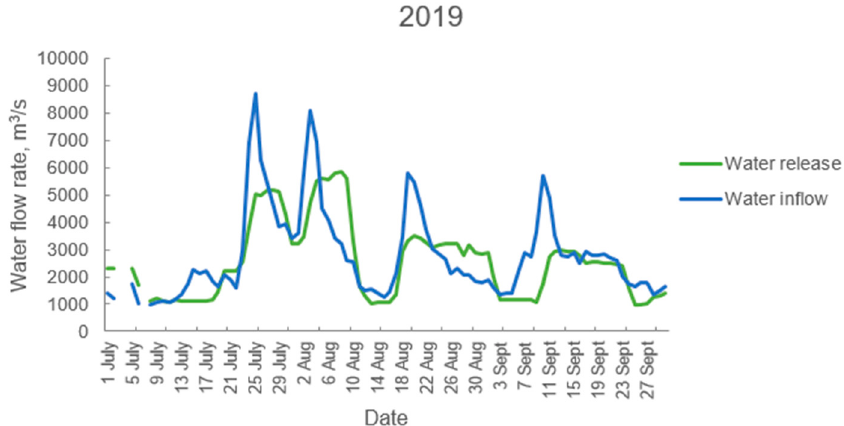
Figure 8. Water inflow to and releases from the Bureya reservoir during high-water period of 2019.